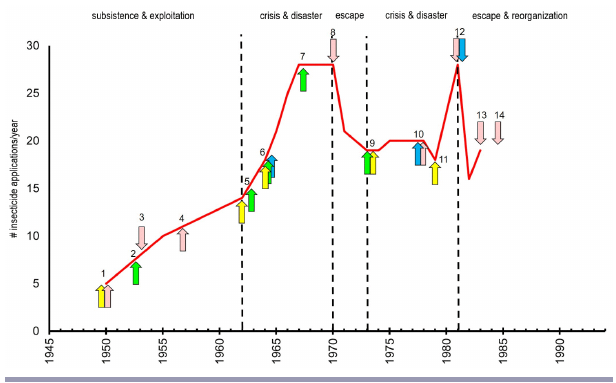
Fig. 3 . Time line representing enabling (upward arrows) and disabling (downward arrows) drivers of pesticide use in cotton production in Nicaragua from 1945 to 1995. The graph indicates the number of insecticide applications per year (Swezey et al. 1986, Murray 1994). Dashed lines indicate approximate times of the transition to a new phase of the treadmill. Colors referring to domains (I–IV) in the framework: (I) farming (yellow), (II) agro-landscapes (green), (III) science and technology (blue), and (IV) society (pink). Numbers and arrows indicate drivers of the treadmill; (1) key pest outbreaks (yellow), economic importance of cotton (pink), (2) increased acreage of cotton production (10,500 ha); (3) one-year ban on methyl parathion; (4) agrarian reform; (5) insecticide resistance (yellow) and decrease natural enemy populations (green); (6) key pests from 5 to 9 (yellow), cotton on 40% of all agricultural land (green), calendar scheduled pesticide applications (blue); (7) drift of pesticide applications; (8) integrated pest management (IPM) program; (9) increase in cotton acreage (175,000 ha), 5-year drought (green), pest outbreaks (yellow); (10) few IPM specialists (blue), loans for pesticide imports, nationalized cotton farms, war (pink); (11) pest outbreak; (12) ban and innovative pesticide policies (pink), regional IPM programs (blue); (13) state decree on mandatory IPM measures; (14) economic crisis, Contra